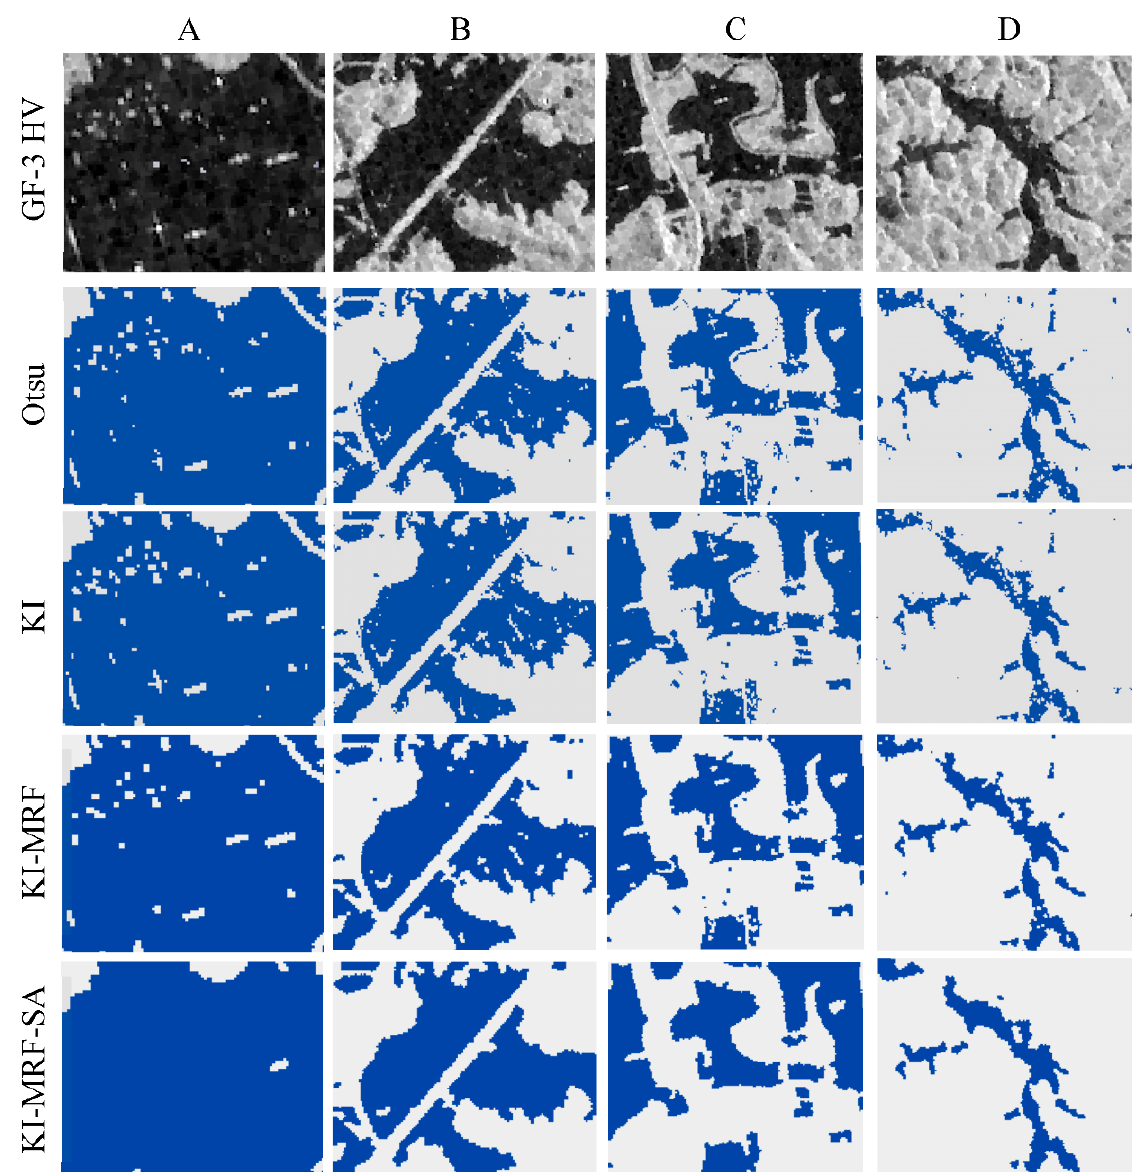
Figure 9. Detail displays of water extraction in Pajiang. The sub fi gures ( A – D ) are some remarkably changed spots in